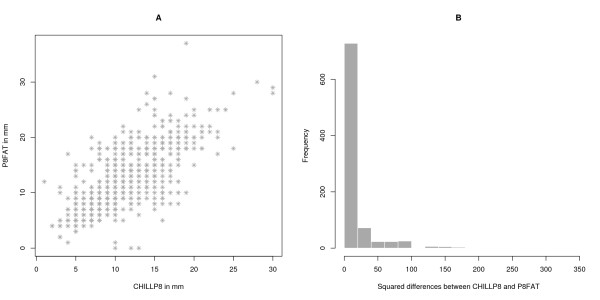
Deviation between the two measurements of the trait. A. Bivariate plot of CHILLP8 and P8FAT for animals in this study, this plot does not show the bivariate density of the two measurements because all the measurements are integers so they stack one on top of the other. B. Histogram of squared differences between CHILLP8 and P8FAT measurements for the GWAS sample, note that the difference between the vast majority of measurements is < 5 mm.